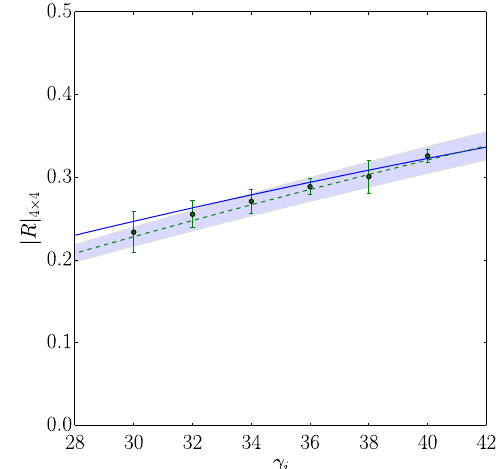
FIG. 6. Measured 4 × 4 transfer-matrix determinant (symbols) compared with the Chambers ’ approximation (solid line) and numerical simulations using the 3D field map (dashed line). The shaded area represents the uncertainty on the simulations due to rf calibration uncertainties.